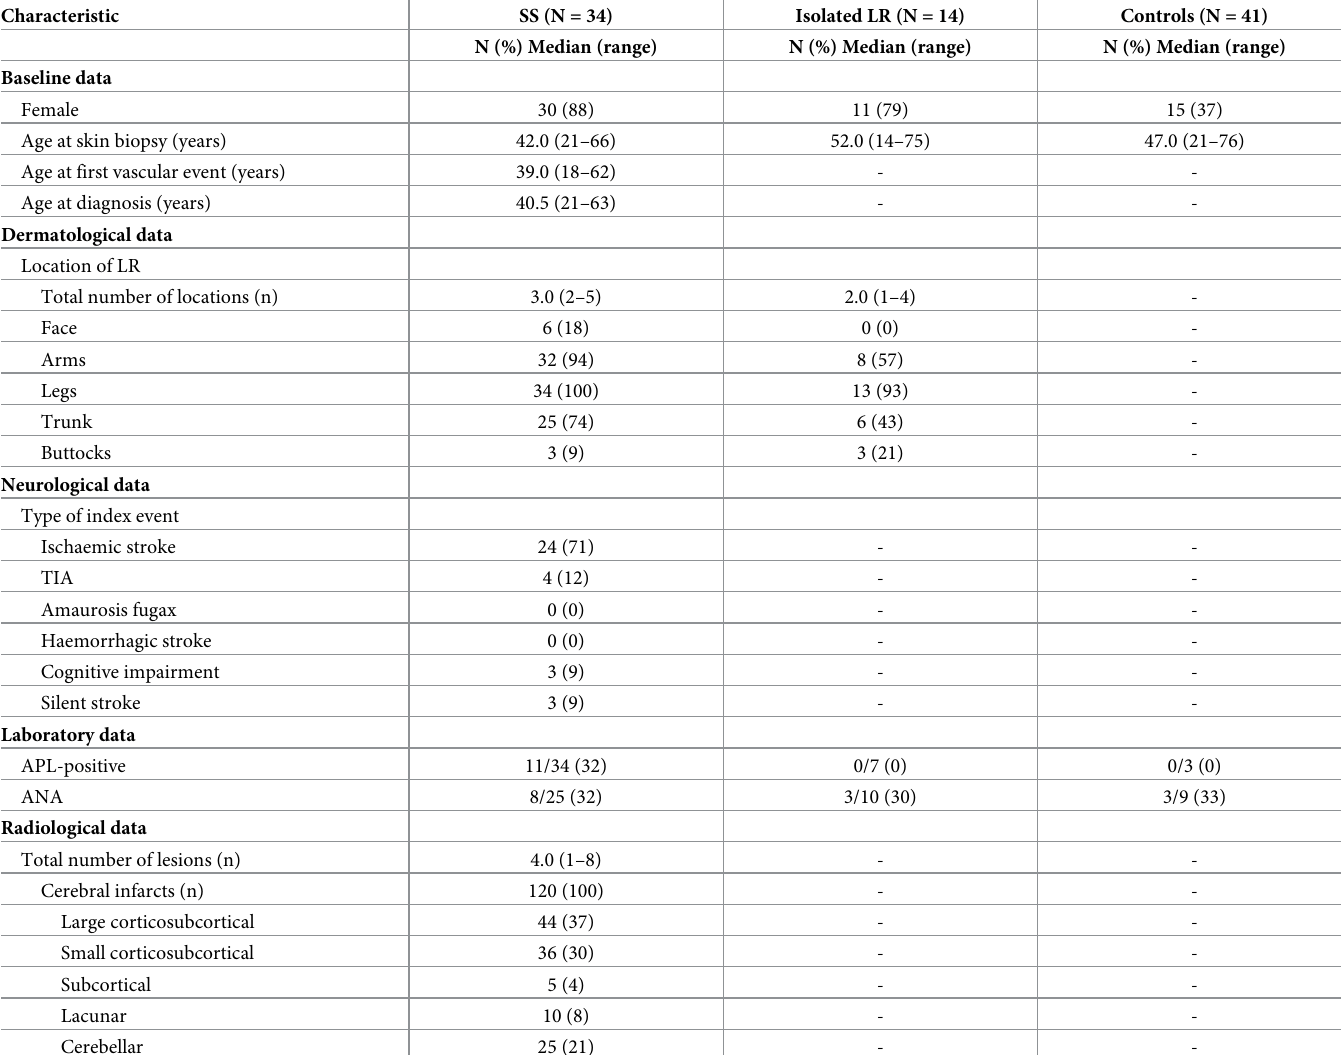
Table 1. Clinical characteristics at